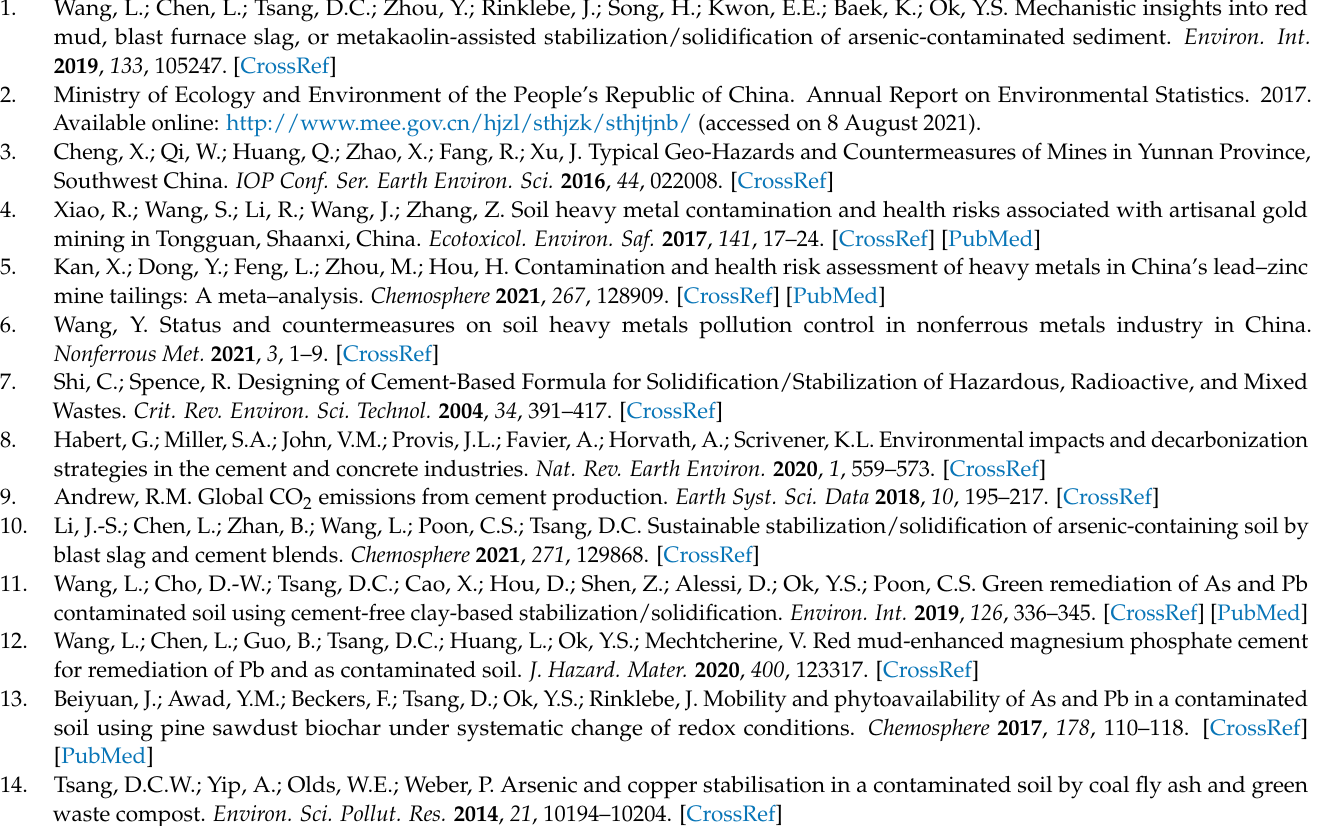
of raw materials and T in Table 2, Table S2: Component analysis result of point in the Figure 4, Table S3: Component analysis result of point in the Figure 5, Table S4: Assessment summary of the S/S performance effects of Na 2 SO 4 , NaOH, Ca(NO 3 ) 2 and Ca(OH) 2 at different doses